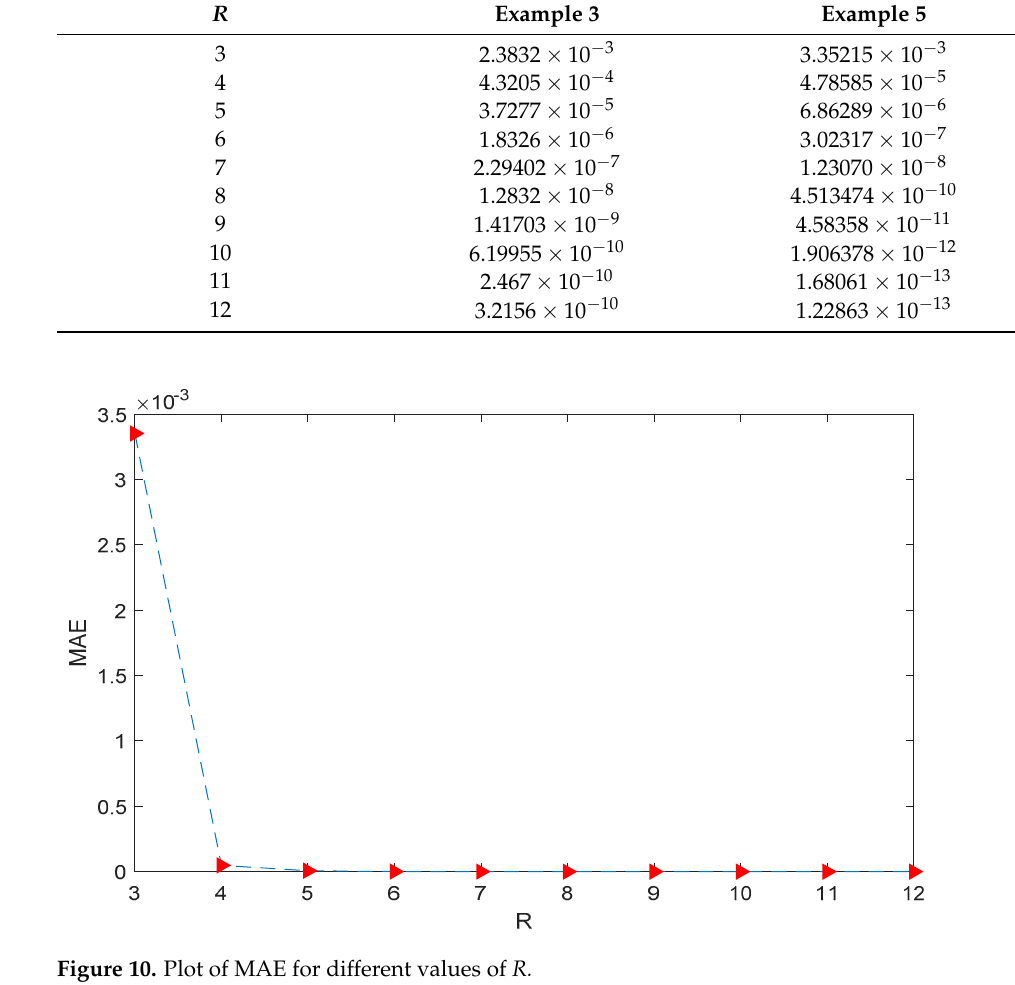
Figure 10. Plot of MAE for different values of 𝑅.